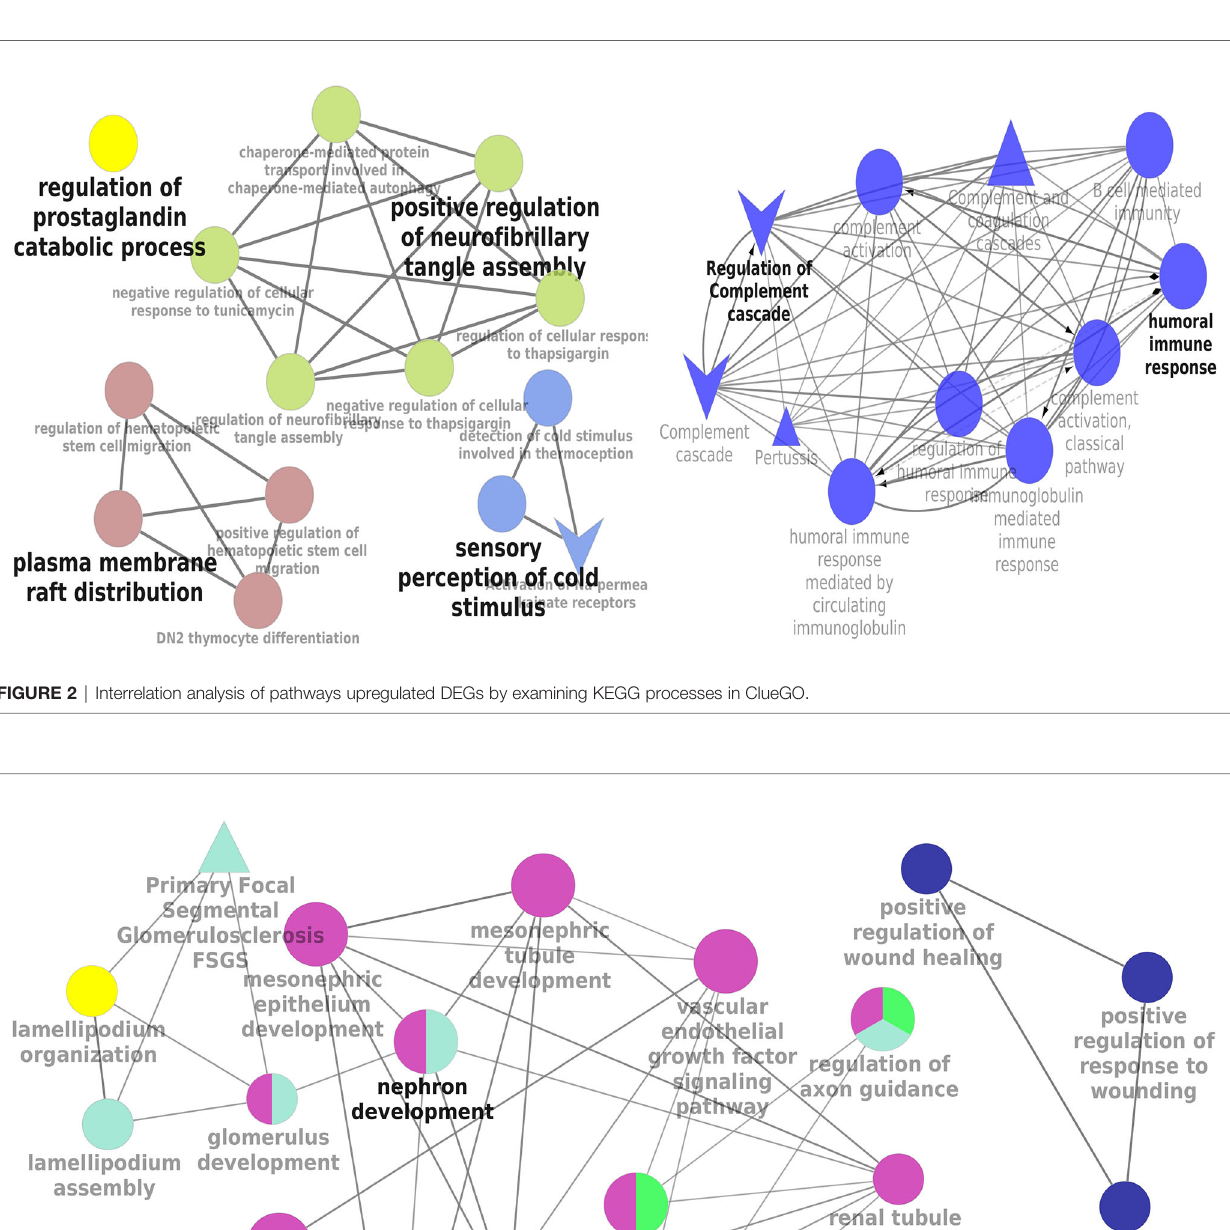
Frontiers in Endocrinology |